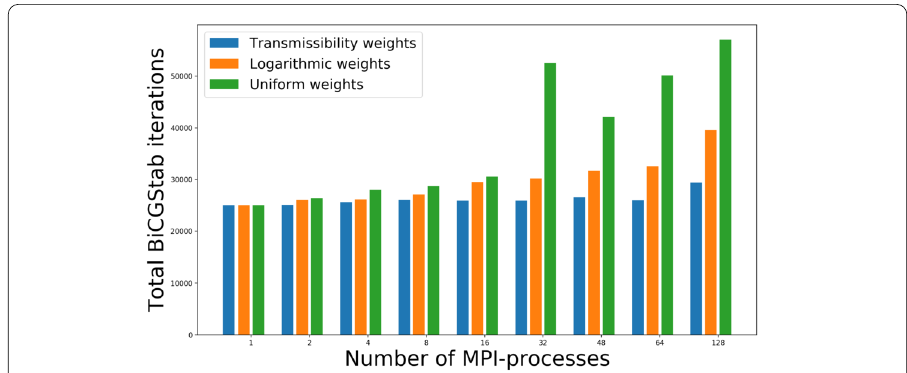
Figure 11 Total number of BiCGStab iterations to run the Norne black-oil benchmark case for three different partitioning strategies and varying numbers of